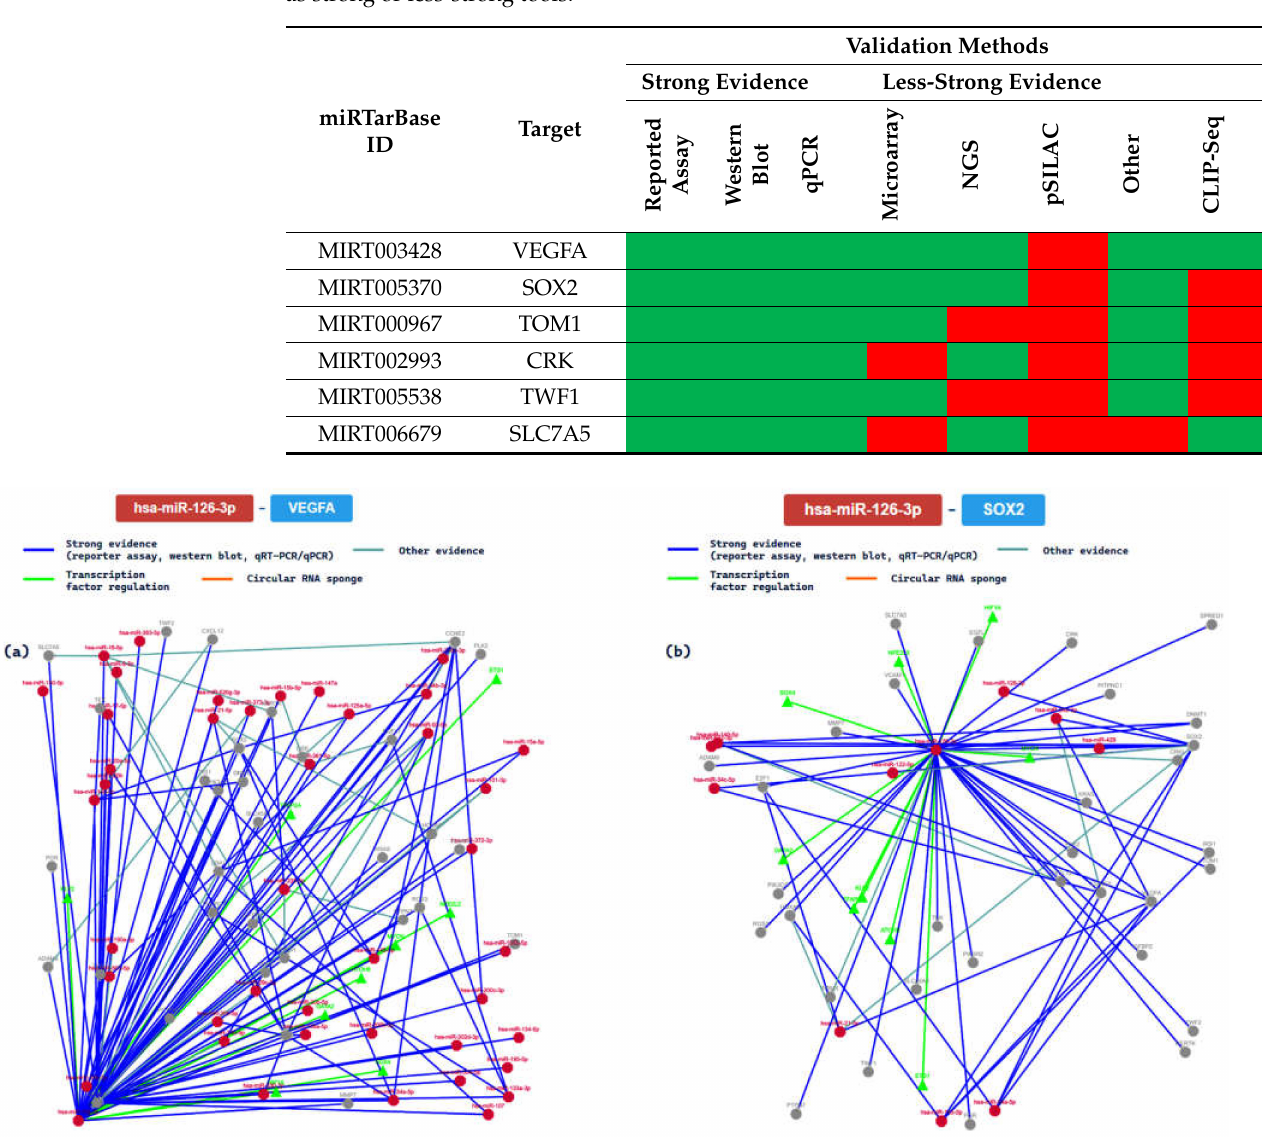
Table 7. Summary of the miRNA interactions with hsa-miR-126-3p, supported with at least 5 positive tools: green = validated methods, red = unvalidated methods. The methods have been distinguished as strong or less-strong tools.